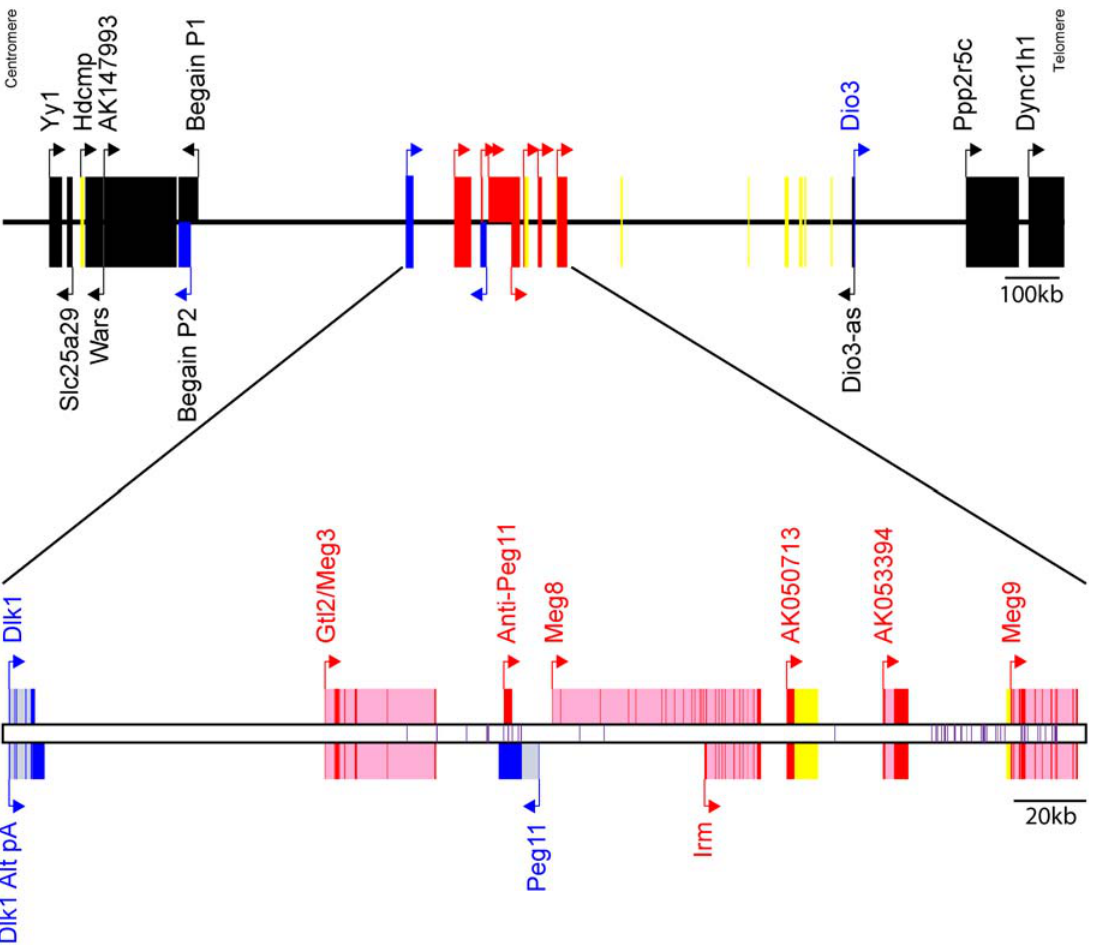
Figure 2. Genomic Organization of Dlk1-Dio3 Imprinted Region. This figure summarizes our results about the imprinting and structure of genes in this mouse region. Arrows denote transcriptional orientations. Genes written in black were shown to be biallelically expressed. Genes drawn in blue are paternally expressed, while those in red are maternally expressed. Genes written in yellow were undetectable by RT-PCR. For Begain transcribed from promoter 2, this transcript was coded blue as it is paternally expressed in sheep in a tissue specific manner, although in this study, RT-PCR failed to amplify a transcript derived from this promoter. Of these, accession numbers, AK141557, AK163826, AK048151, and AK044800, correspond to unspliced ‘‘transcripts’’ whose cDNA sequence ends in a polyA stretch of genomic DNA, suggesting that these ‘‘cDNAs’’ may be genomic DNA contamination in the Riken mouse cDNA libraries. For the bottom panel, exons are dark colored while introns are light. Purple lines represent the position of microRNA precursors. In all, fifty-two mouse microRNA precursors as listed in Table 2 map to this imprinted region.